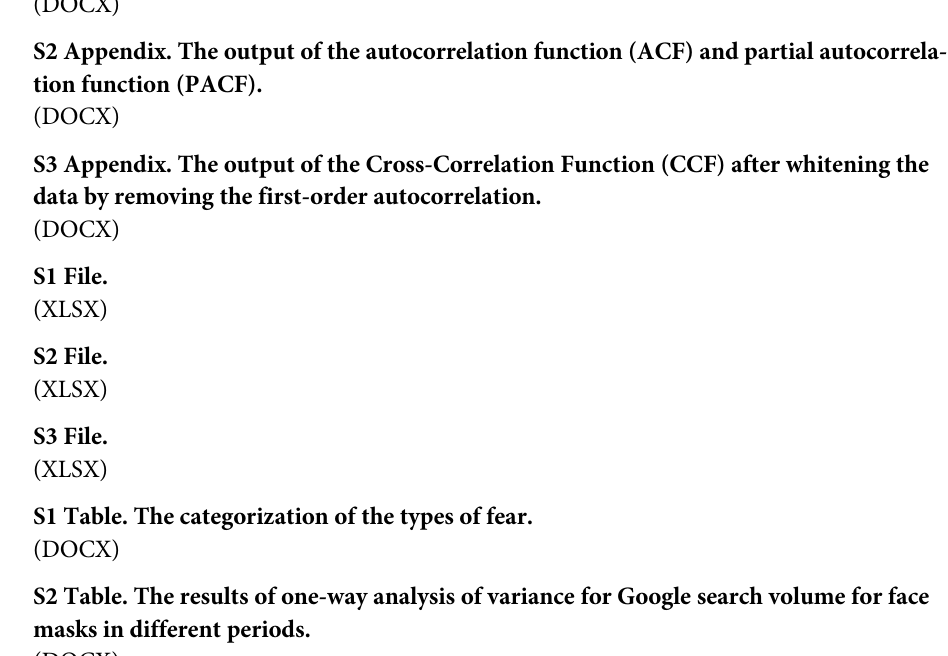
S3 Table. The results of post hoc multiple comparisons for Google search volume for face masks in different